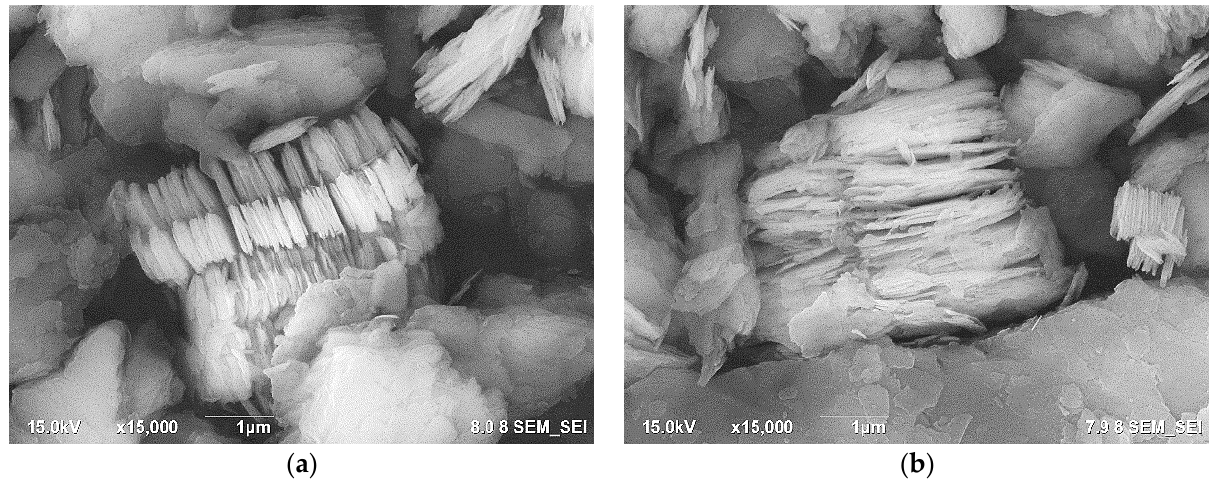
Figure 3. FE-SEM images ( a ) kaolin and ( b ) metakaolin. The images reveal the platy morphology of kaolin crystallinity, which is largely preserved in an amorphous metakaolin.